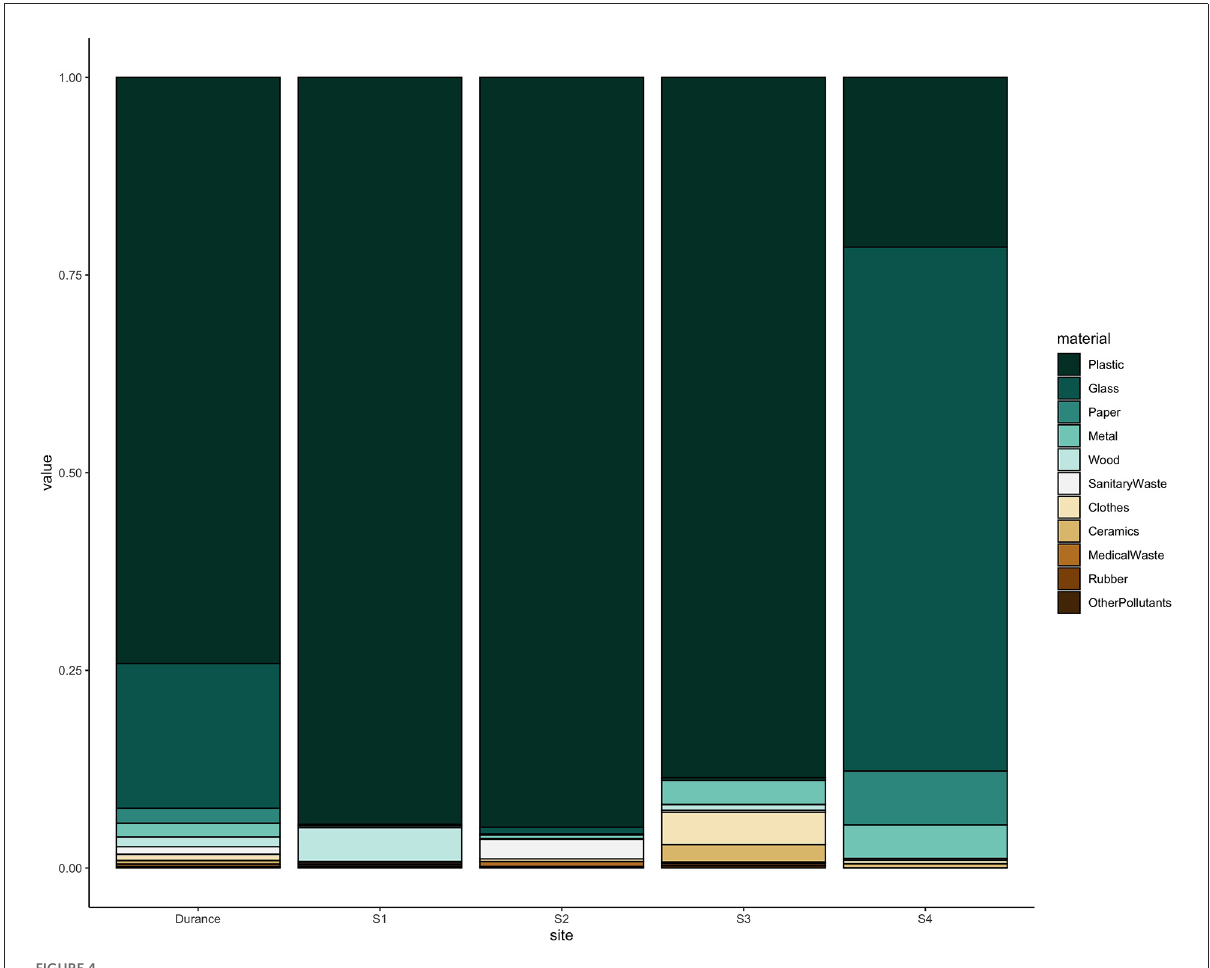
FIGURE4 Percentage composition of materials of litter